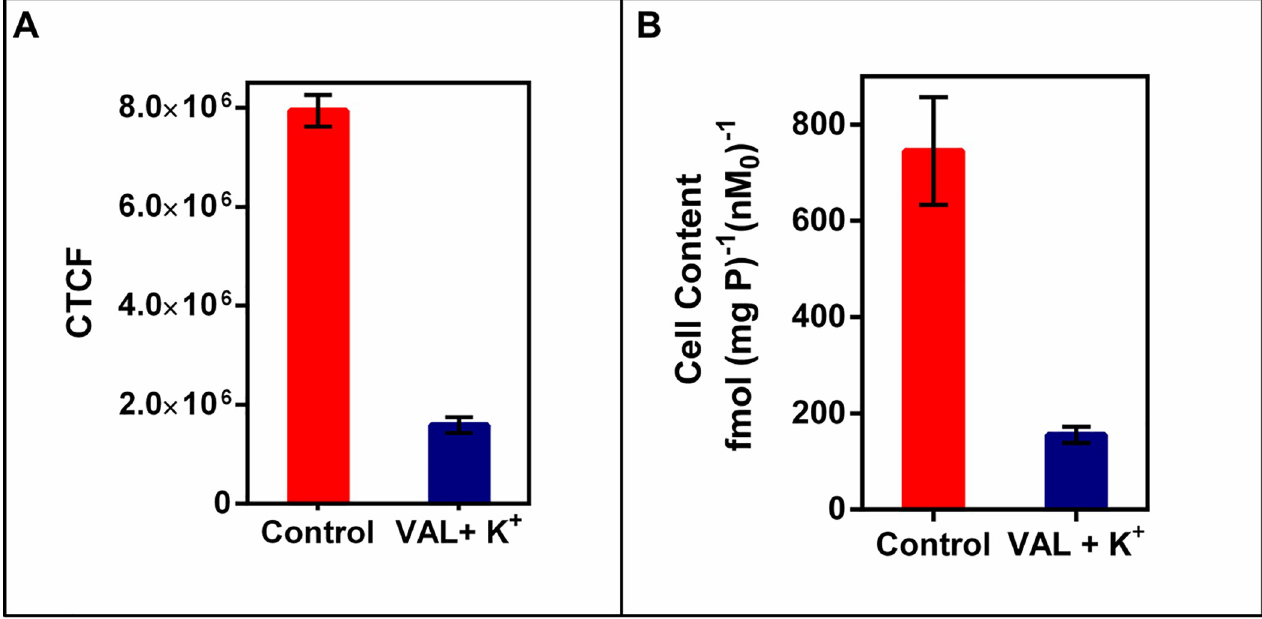
Fig 10. (A) Cellular accumulation of Galmydar in rat cardiomyoblasts H9c2(2–1) either in control buffer or in presence of 130 mM K + buffer containing valinomycin (1 μ g/mL), the potassium ionophore . Shown is a net uptake at 60 minutes (CTCF) derived from live-cell imaging data. The bar represents the mean of 4 determinations; the line above the bar denotes ± SD. Note dissipation of prevalent electronegative gradients on membranes resulting from influx of K + into cells leading to 80% lower uptake (red bar) compared with that of control (blue) under identical conditions. (B) Cellular accumulation of 67 Ga- Galmydar in rat cardiomyoblasts H9c2(2–1) either in control buffer or in presence of 130 mM K + buffer containing valinomycin (1 μ g/mL), the potassium ionophore . Shown is a net uptake at 90 minutes. Data are reported represented as fmol of 67 Ga-Galmydar (mg protein) − 1 (nM 0 ) − 1 , wherein nM 0 representing the total concentration of 67 Ga-complex in the extracellular buffer. The bar represents the mean of 4 determinations; the line above the bar denotes ± SD. Note uptake profiles of the radiotracer correlate with that of fluorescence live cell imaging.